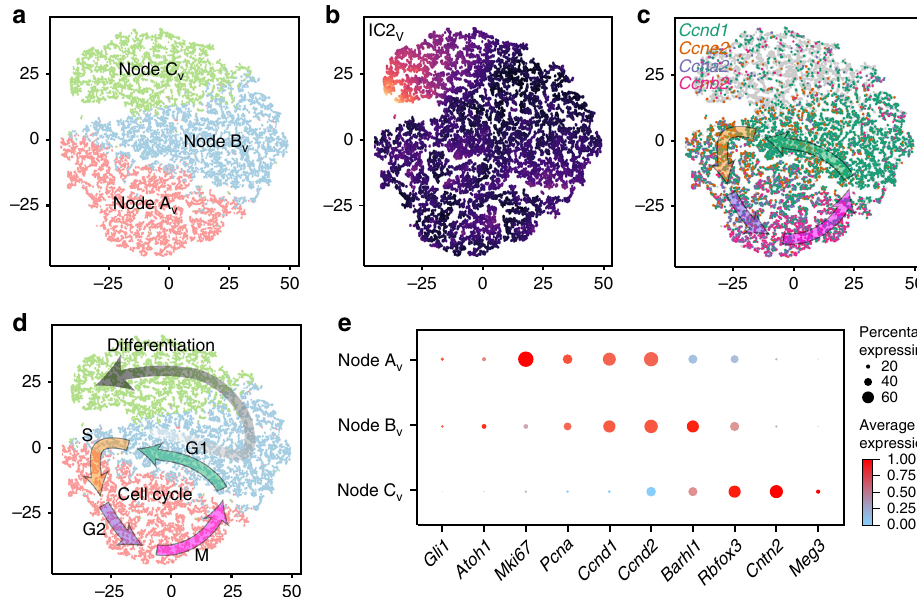
Fig. 4 ICA on CGNP-like tumor cells demonstrates self-renewal and differentiation. a t-SNE projection of CGNP-like cells from vehicle-treated tumors directed by ICA, with Nodes A V – C V color-coded. b ICA t-SNE as in a , with IC2 V color-coded from yellow (high) to blue (low). c Feature plot of Ccnd1, e2, a2 and b2 on ICA t-SNE in a . Arrows are placed according to indicated marker expression and show the expected sequence of Cyclins through the cell cycle. d Pseudotime trajectories inferred by IC2 V and Cyclin expression, plotted on ICA t-SNE in a . e Dot Plot showing expression of developmental markers across Nodes A V – C V . Average expression values are calculated from all cells in each Node, including cells with no detectable copies of the